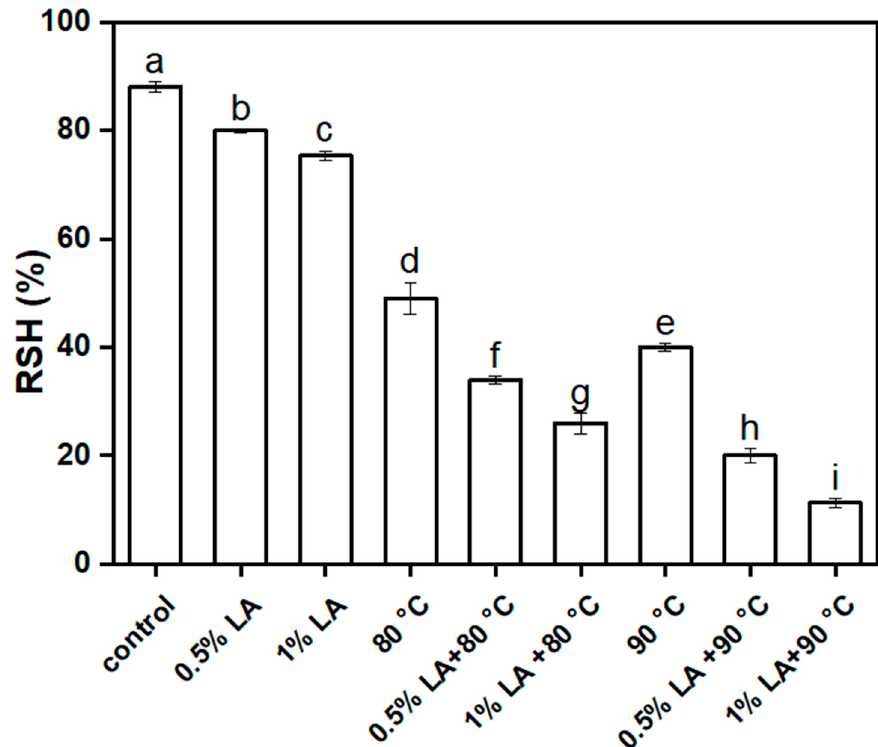
Figure 6. Changes of spore hydrophobicity after different treatments for 30 min. Different lowercase letters indicate significant differences between treatments ( p < 0.05).